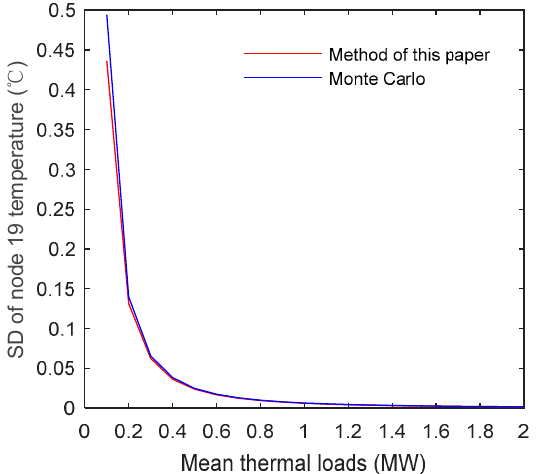
Figure 6. Relationship between the node temperature standard deviation of node 19 and mean thermal load (Test 4: L = 500 m ; σ ϕ = ±10%).